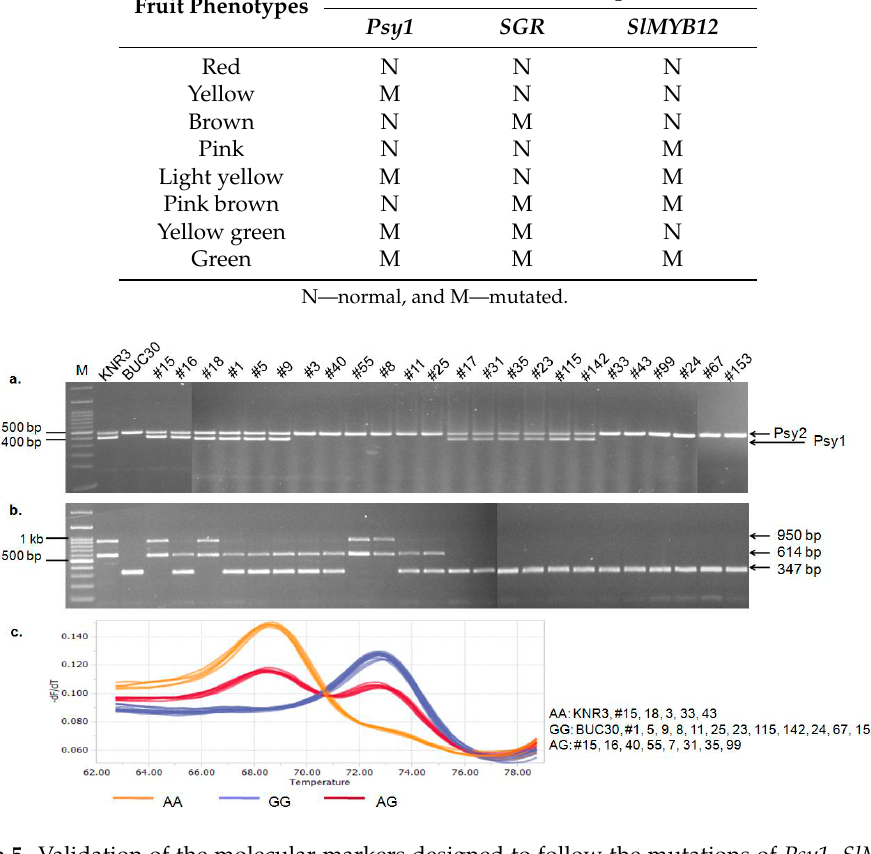
Figure 5. Validation of the molecular markers designed to follow the mutations of Psy1 , SlMYB12 , and SGR using randomly-selected plants from an F 2 population segregating for eight fruit color phenotypes. ( a ) PCR amplicons of mutated Psy1 using Psy1CDSF+Psy1R5 primers; ( b ) PCR amplicons of mutated SlMYB12 using MYB12-603del-aF1+aR6 and MYB12-603del-aF1+aR5